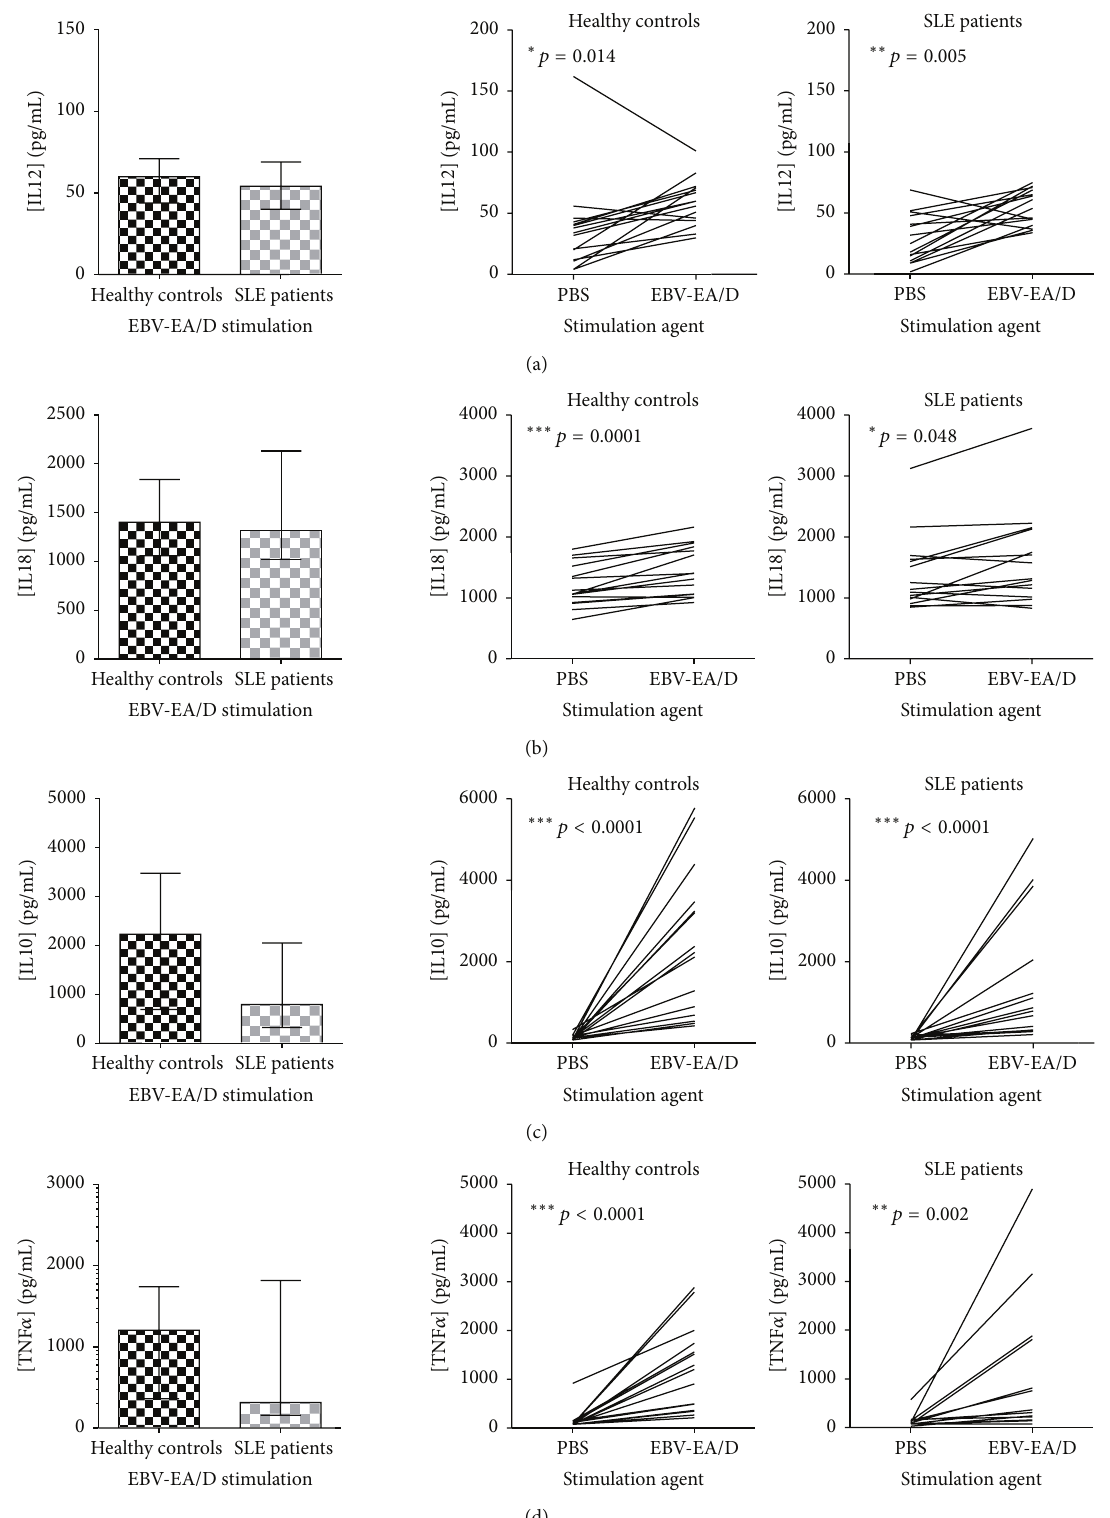
Figure6:Cytokines,IL12(a),IL18(b),IL10(c),andTNF 𝛼 (d),withsimilarinductioninSLEpatientsandinHCsuponEBV-EA/Dstimulation. IL12 (a), IL18 (b), IL10 (c), and TNF 𝛼 (d) quantified in dried blood spot samples from SLE patients (with normal lymphocyte levels, 𝑛 = 15 ) and sex- and age-matched HCs ( 𝑛 = 15 ) by multiplexed Luminex assay with addition of HBR+. Left: cytokine concentrations (pg/mL) in SLE patients and HCs upon EBV-EA/D stimulation. Data are presented as median with interquartile range. 𝑝 values for comparison of SLE patients and HCs are 0.639, 0.600, 0.107, and 0.600 in (a), (b), (c), and (d), respectively. Right: induction of cytokines (pg/mL) from basic levels (PBS stimulation) by EBV-EA/D stimulation in SLE patients and